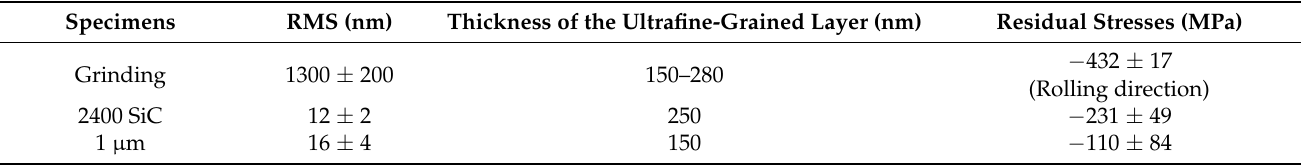
Table 1. Microstructural characterization of the effect of mechanical surface treatment on the top surface and subsurface of 304L SS. RMS values are reported for the roughness characterization. Thickness of the ultrafine-grained layer determined by TEM and residual stresses measured by XRD are